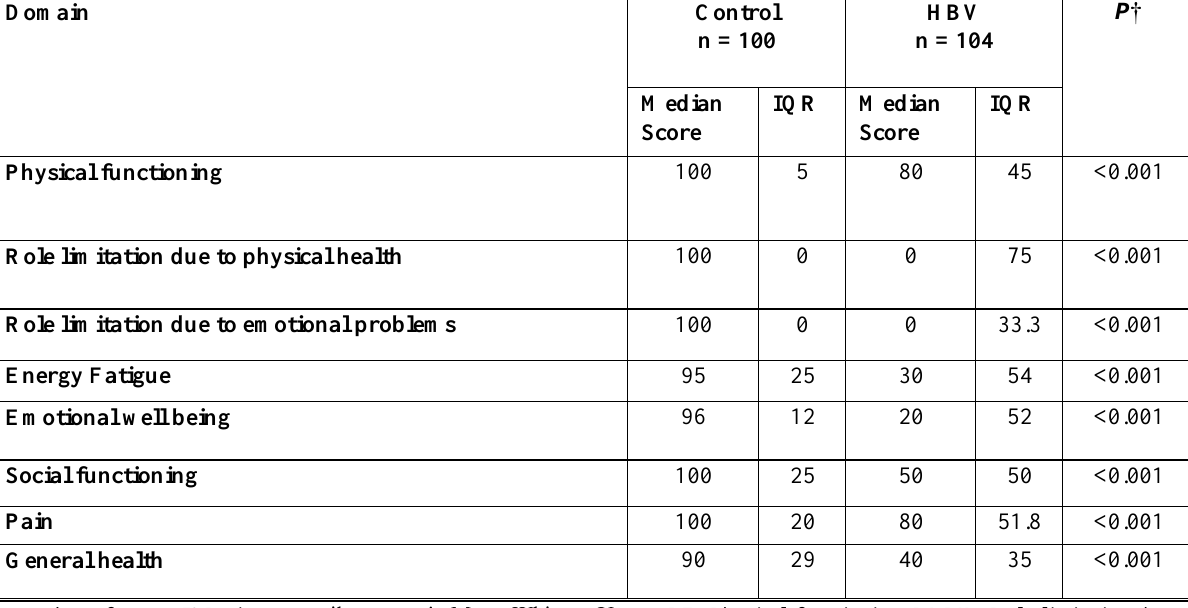
Table 3. Comparison of median values related to short form domain average scores between patients with chronic hepatitis B infection and control